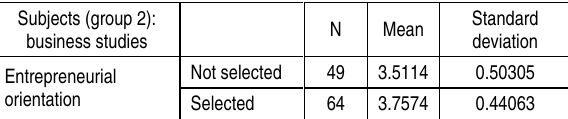
Table 2. Hypothesis testing one – group statistics